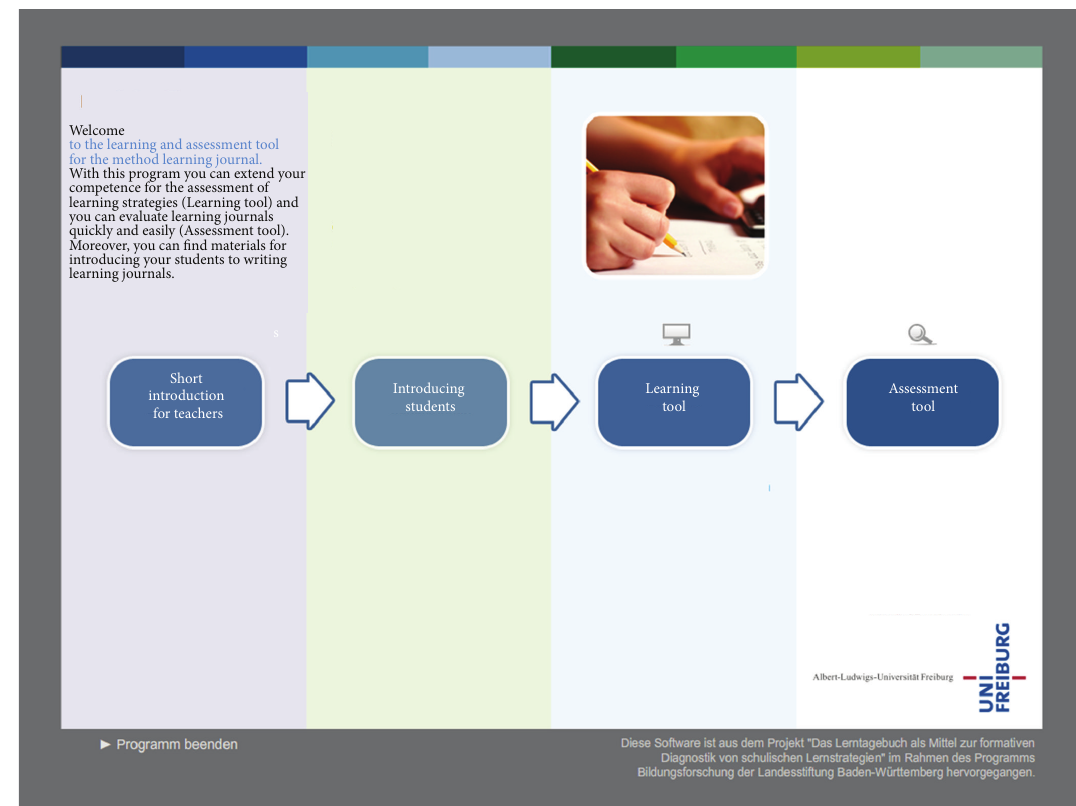
Figure2:StartmenuoftheCBLEwithfoursections:“shortintroductionforteachers,”“introducingstudents,”“learningtool,”and“assessment tool.” Short descriptions about what can be expected in the sections appear when learners mouse over the four